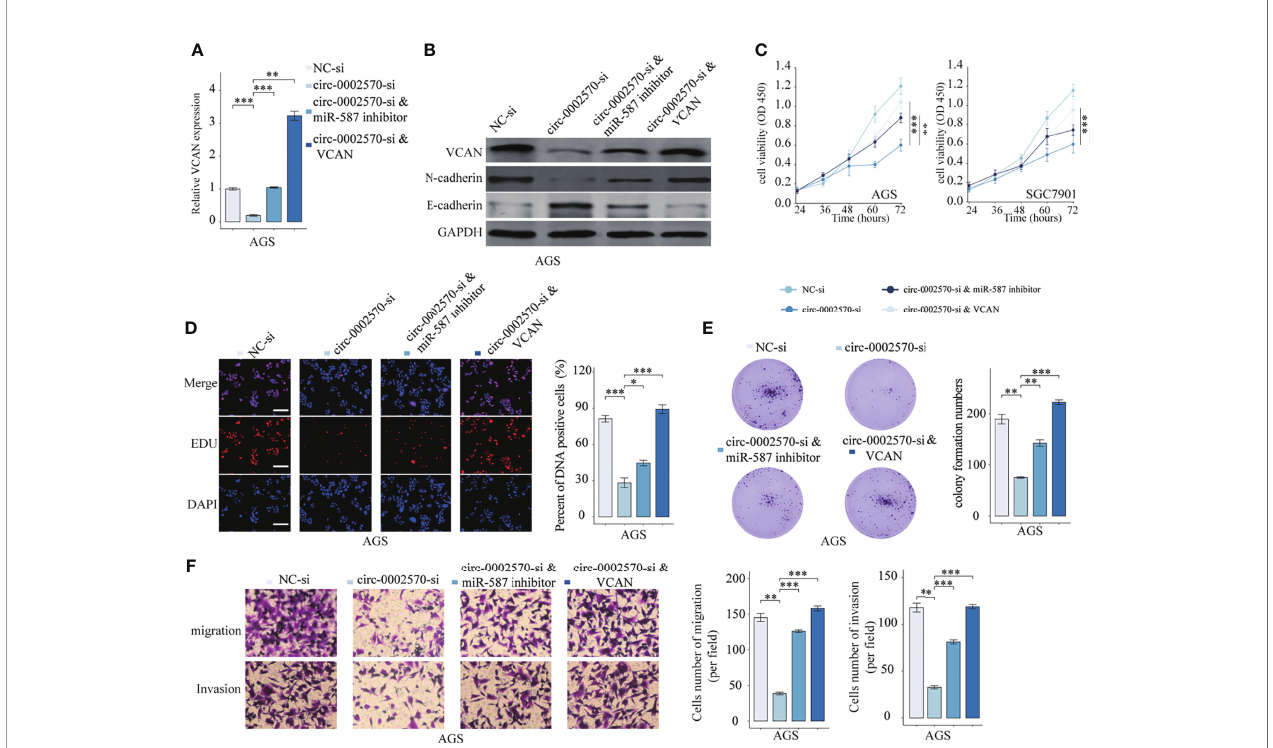
FIGURE 8 | Circ-0002570 promoted GC progression via regulating miR-587/VCAN axis. (A,B) RT-PCR and Western blot determined the expression of VCAN in AGS cells transfected with NC-sh, circ-0002570-sh, circ-0002570-sh+miR-587 inhibitor, or circ-0002570-sh+pcDNA-VCAN. (C) CCK-8 assays, (D) Edu assays, (E) Colony formation assay, and (F) transwell assays of AGS cells after treatments. * p < 0.05, ** p < 0.01, *** p <